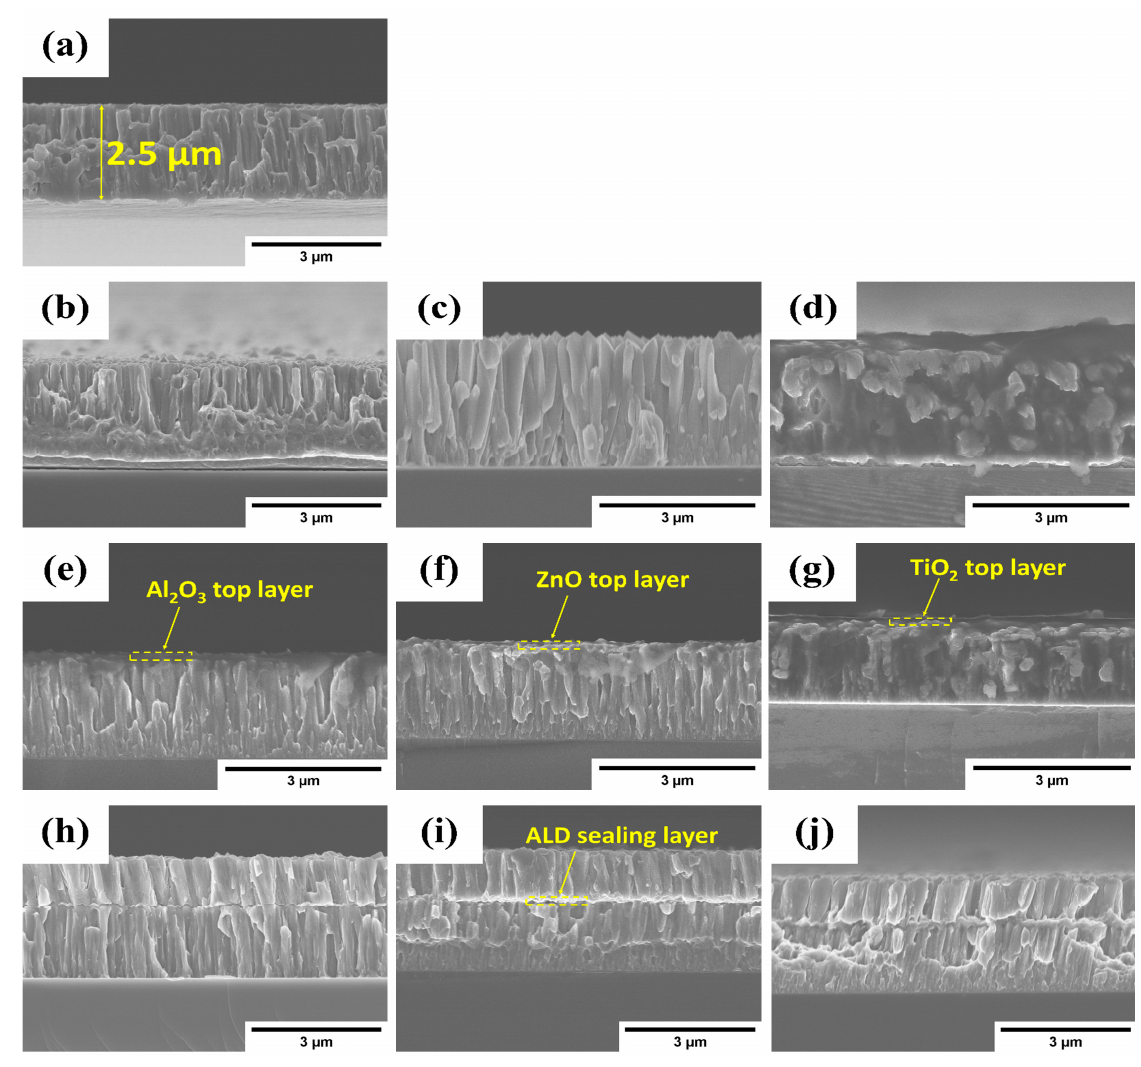
Figure 4. SEM cross-section images of ( a ) AlZr, ( b ) Al 2 O 3 /AlZr, ( c ) ZnO/AlZr, ( d ) TiO 2 /AlZr, ( e ) AlZr/Al 2 O 3 , ( f ) AlZr/ZnO, ( g ) AlZr/TiO 2 , ( h ) AlZr/Al 2 O 3 /AlZr, ( i ) AlZr/ZnO/AlZr, and ( j ) AlZr/TiO 2 /AlZr.